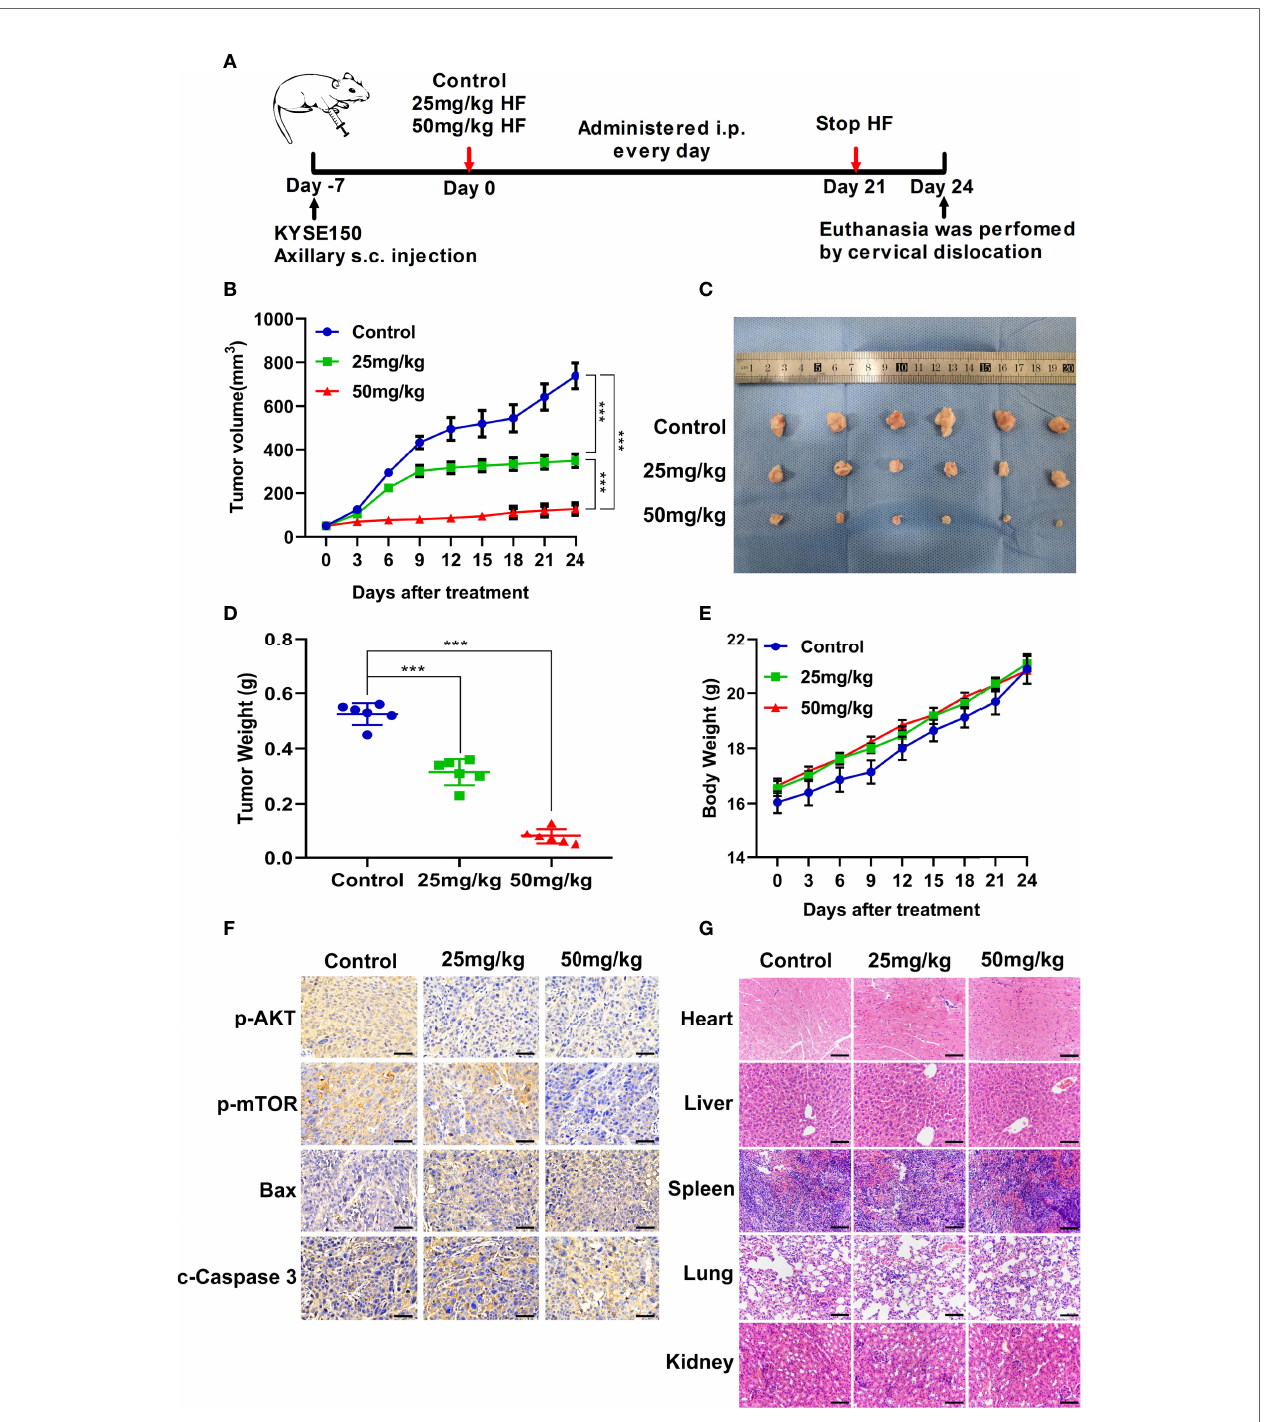
FIGURE 7 | HF suppresses the growth of mouse ESCC xenograft tumors. (A) BALB/c-nu mice implanted with KYSE150 xenograft tumors were treated daily with an equal volume of saline (control group) or HF (25 or 50 mg/kg) by intraperitoneal injection for total 21 days. (B) The tumor volume was measured every 3 days, and the difference in tumor volume between HF treated and control mice is shown. *** P < 0.001. (C) After euthanasia of mice, subcutaneous xenografts were removed and photographed. (D) The removed xenograft tumors were weighed and graphed for statistical analysis. *** P < 0.001 vs the control group. (E) Body weights of tumor-bearing mice were measured every 3 days in the HF-treated and control groups. (F) Expression levels of p-AKT, p-mTOR, Bax, and cleaved-Caspase 3 were detected by immunohistochemistry in the xenograft tumors. Magni fi cation, ×400; scale bars = 50 µm. (G) H&E staining of the heart, liver, spleen, lung, and kidney of experimental mice shows no pathological changes in the organ tissues of any group. Magni fi cation, ×200; scale bars = 100